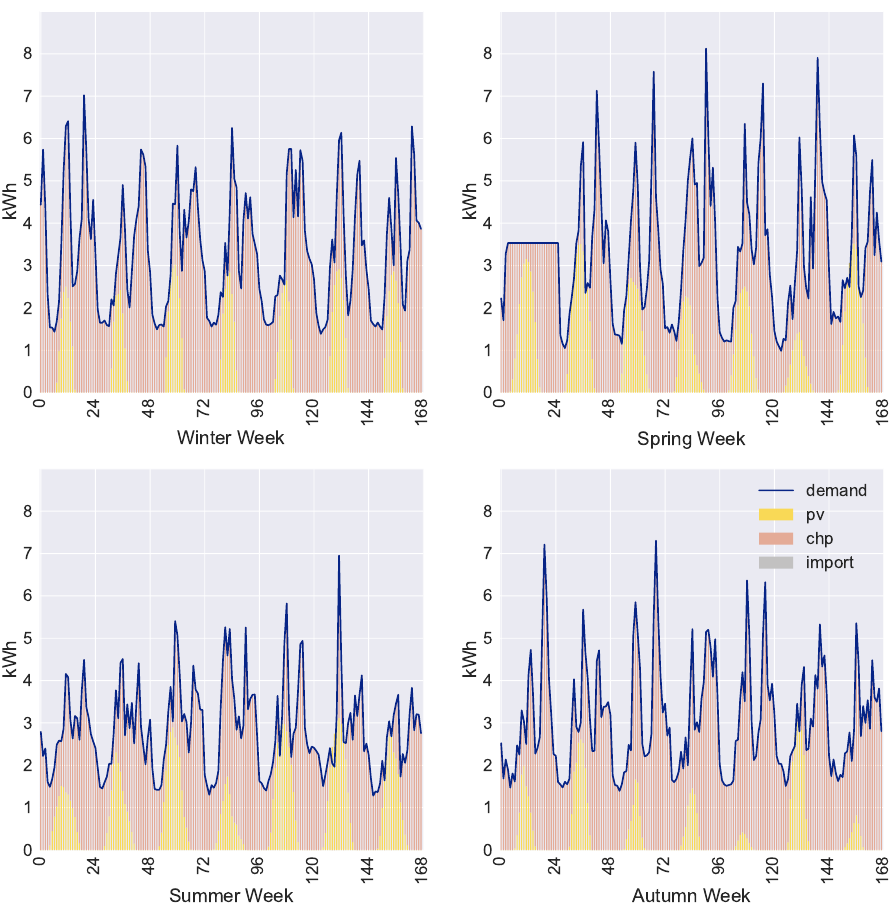
Figure 10. Hourly electricity production of four representative weeks: Location